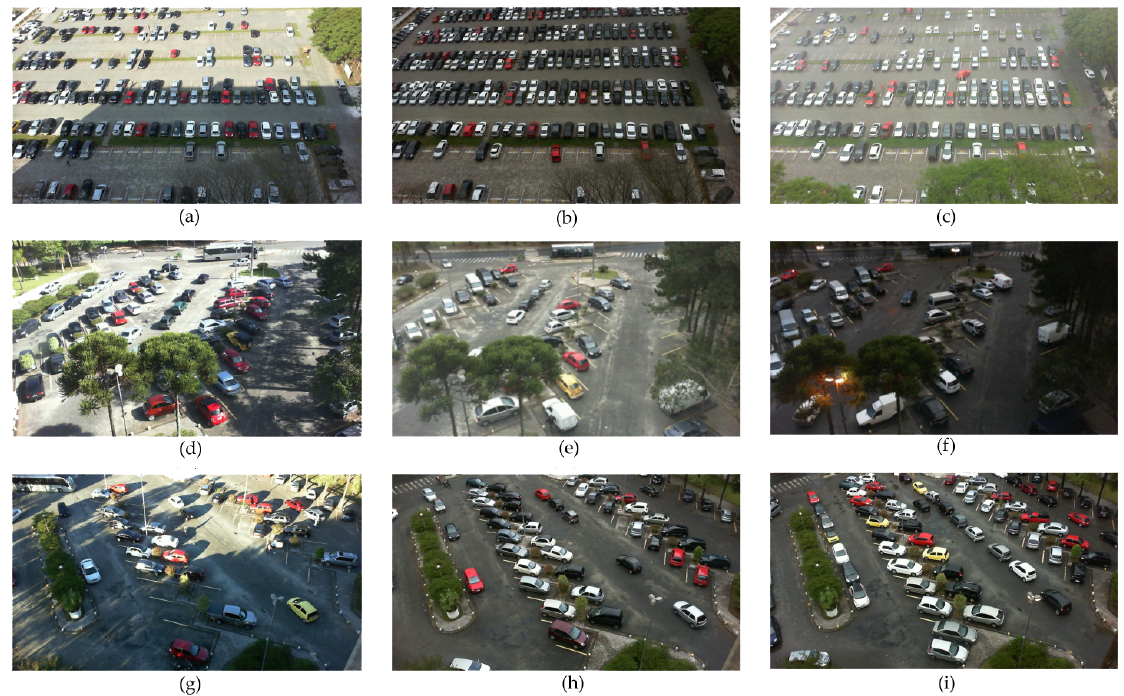
Figure 3. Examples of photos taken under various weather conditions [4]: ( a – c ) from PUCPR (sunny, overcast, rainy respectively); ( d – f ) from UFPR04 (sunny, overcast, rainy respectively); ( g – i ) from UFPR05 (sunny, overcast, rainy